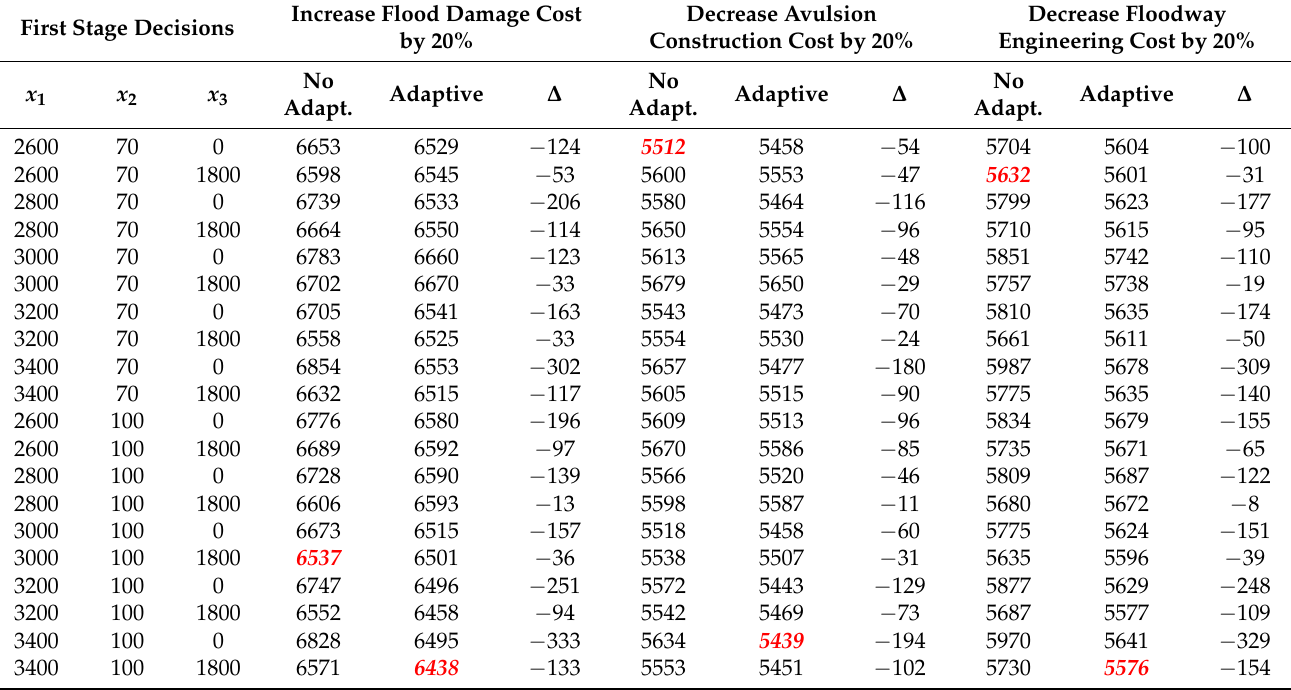
Table 7. Sensitivity to cost assumptions of the expected benefit of allowing adaptive decisions (changes in x 1 and/or x 3 in second stage) for each of the first stage decisions (Bold red italics indicates optimal